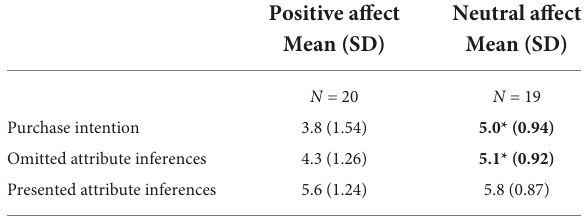
TABLE 1 Experiment 1: Purchase intention and attribute inferences as a function of positive